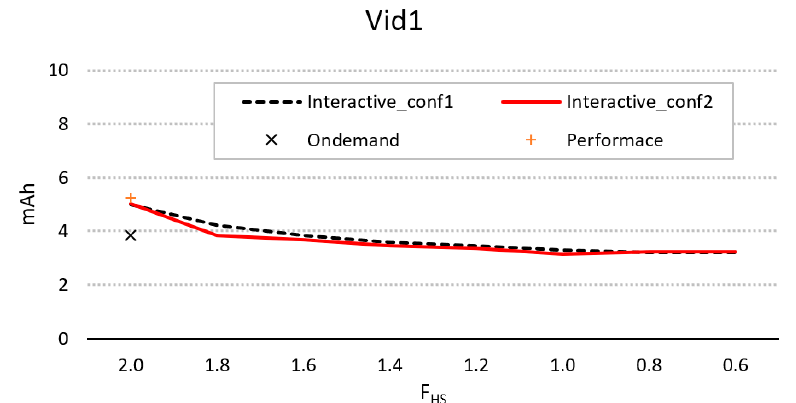
Figure 8. Evolution of energy consumption for the interactive controller for configurations 1 and 2, using di ff erent values of F hs , compared to consumption using Ondemand and Performance .